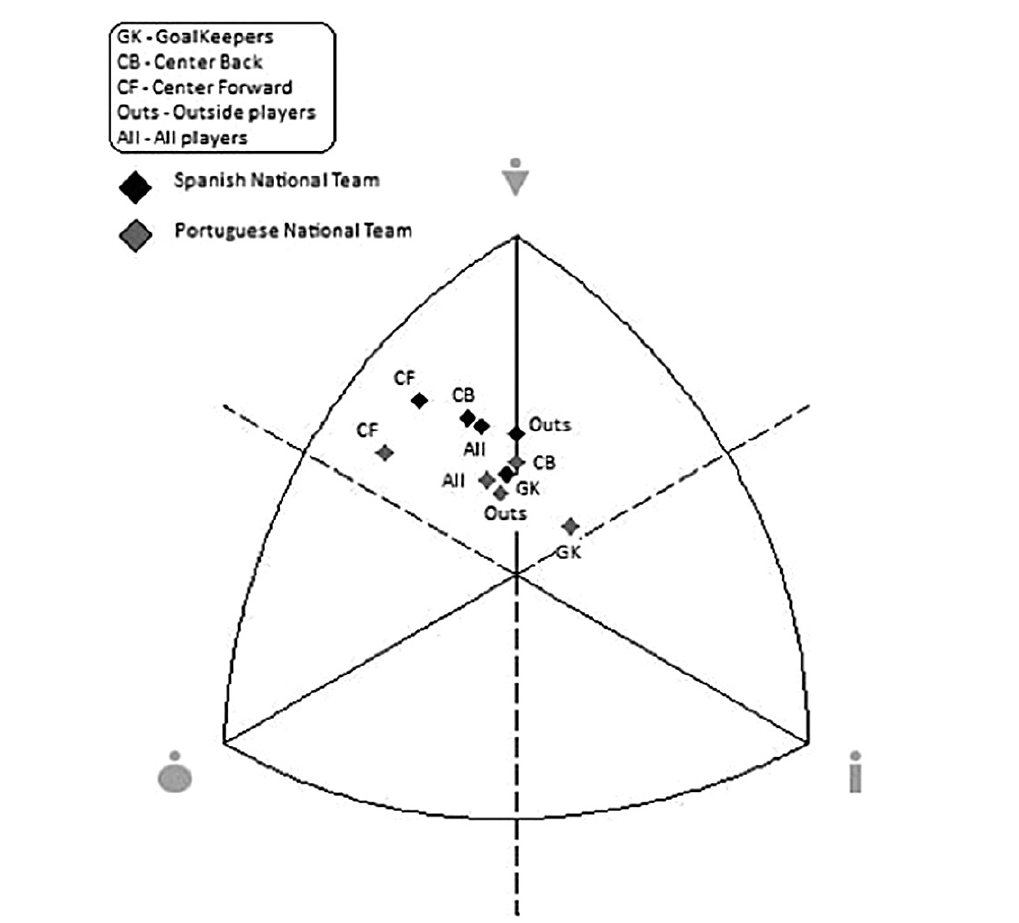
Figure 1. Somatochart of waterpolo players from Spanish and Portuguese national teams by specialized playing positions and for the total sample (all